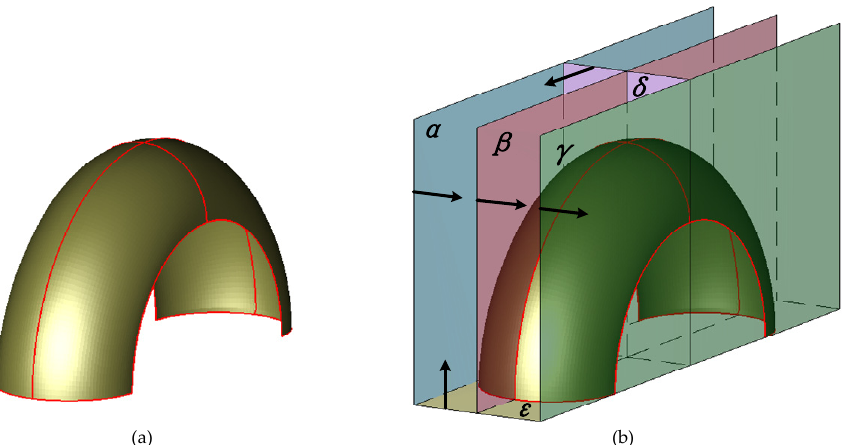
Figure 4. Schematic diagram of the closed-loop division: ( a ) the example model and the cross-contour polylines of it; ( b ) the formed subspace after using approximate planes to cut polylines. As shown in Figures 4 and 5, the contour polylines 𝑎, 𝑏, 𝑐, 𝑑 are cut by the approximate planes and coded according to the above rules. The initial coding result is shown in Table 1.